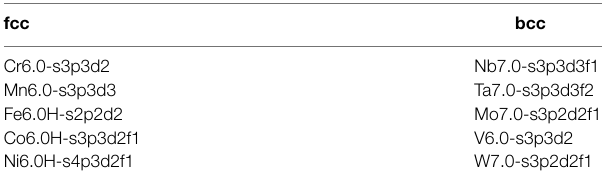
TABLE 1 | Atomic orbital basis sets for constituent element of fcc and bcc